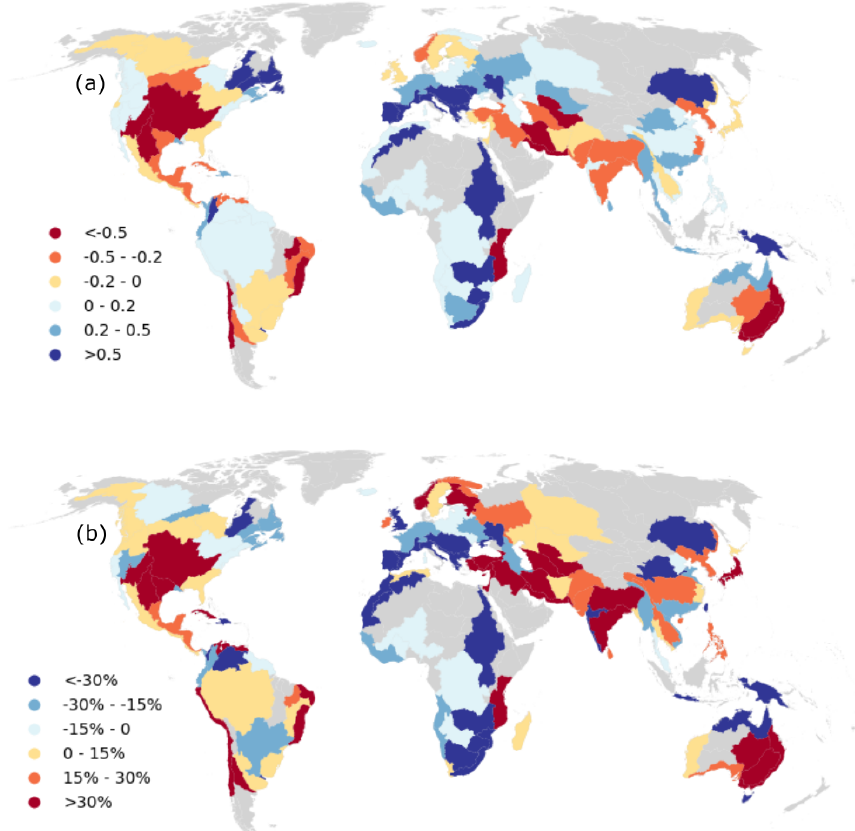
Figure 5. The change in resilience (a) and vulnerability (b) between pre-2000 and post-2000 (gray shade: no reservoir data).